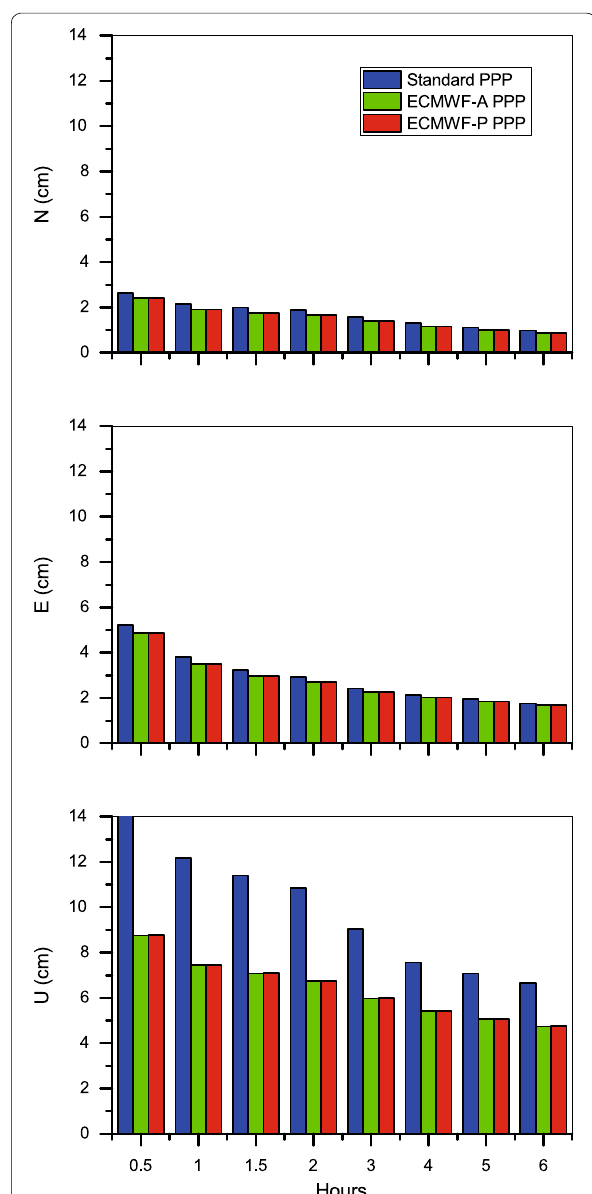
Fig. 5 RMS values of BeiDou-only results for the north/east/up components after the processing of different session length (0.5, 1, 1.5, 2, 3, 4, 5, 6 h) from the BeiDou stations in Fig. 1 over a sample period from February 6 to March 8, 2016. Blue denotes the standard PPP solution, green and red are the ECMWF-augmented PPP solution with analysis and prediction data,